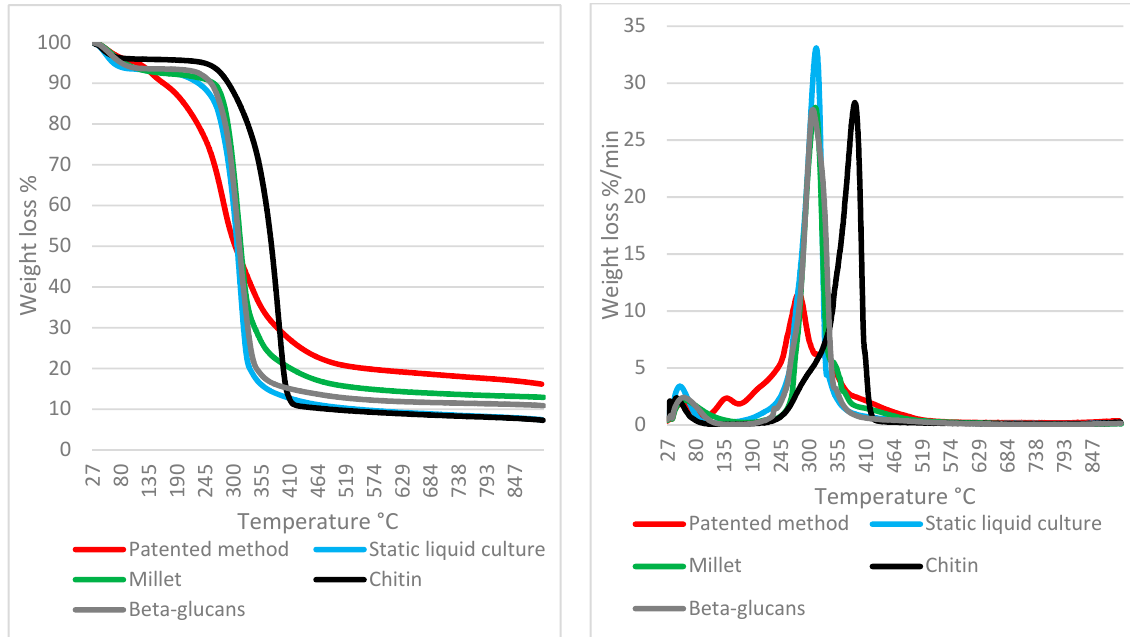
0102030405060708090100 Figure 4. TGA ( left ) and DTGA ( right ) profiles of Fomitopsis iberica (10) (pure mycelium grown in liquid and mat grown on slurry) compared to reference materials. Figure 5. TGA ( left ) and DTGA ( right ) profiles of Lenzites betulinus (16) (pure mycelium grown in liquid and mat grown on slurry) compared to reference materials. Taking the abovementioned strains as an example, the pure mycelium (strain 16) pro- file in Figure 5 almost overlaps with the slurry mat profile; the mass loss behaviors of both strains are both visibly driven by the component decomposition of β -glucan. However, the major difference between strain 16 and strain 10 is that the β -glucans in pure mycelium are much more developed in the latter (10), whereas the slurry mat is less variable in terms of its weight loss percentage. β -glucans are also the major determinant in the millet profile since cereals are also rich in β -glucans.